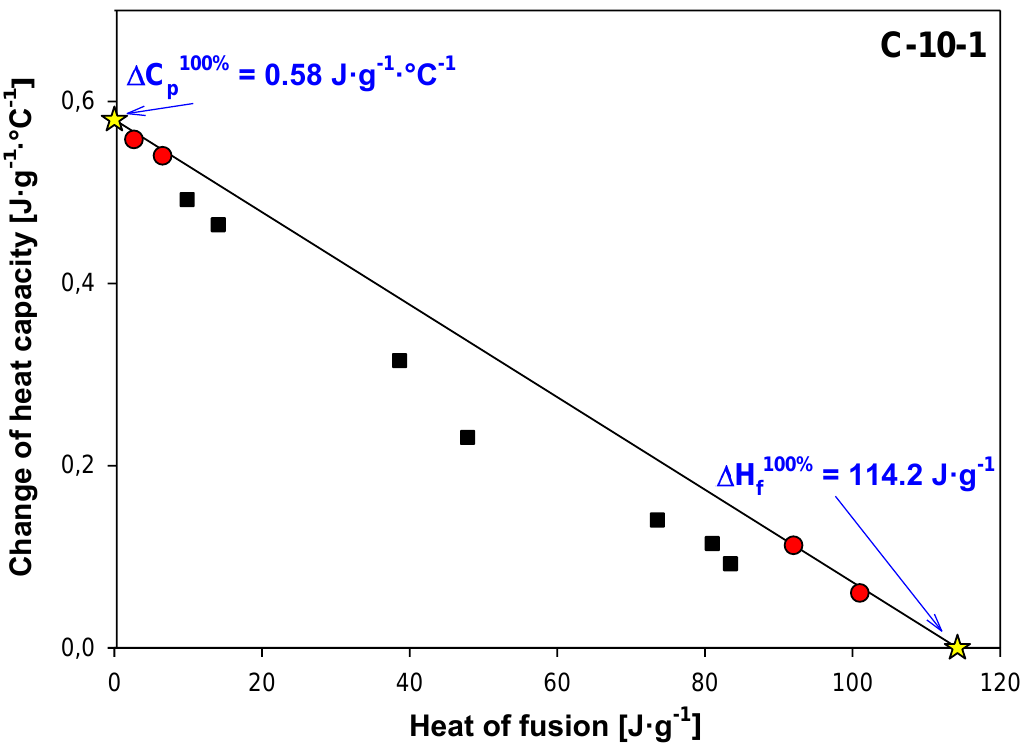
Figure 6. Dependence of the heat capacity change at the glass transition temperature versus the heat of fusion of the semicrystalline nanocomposites P3HB containing 1 wt.% of Cloisite ® 30B (denoted as C-10-1). The red points are characteristic of the two-phase model of nanocomposite, and the black squares show the three-phase model of C-10-1. The solid straight line indicates the full amorphous and full crystalline C-10-1 samples represented by the yellow star points.